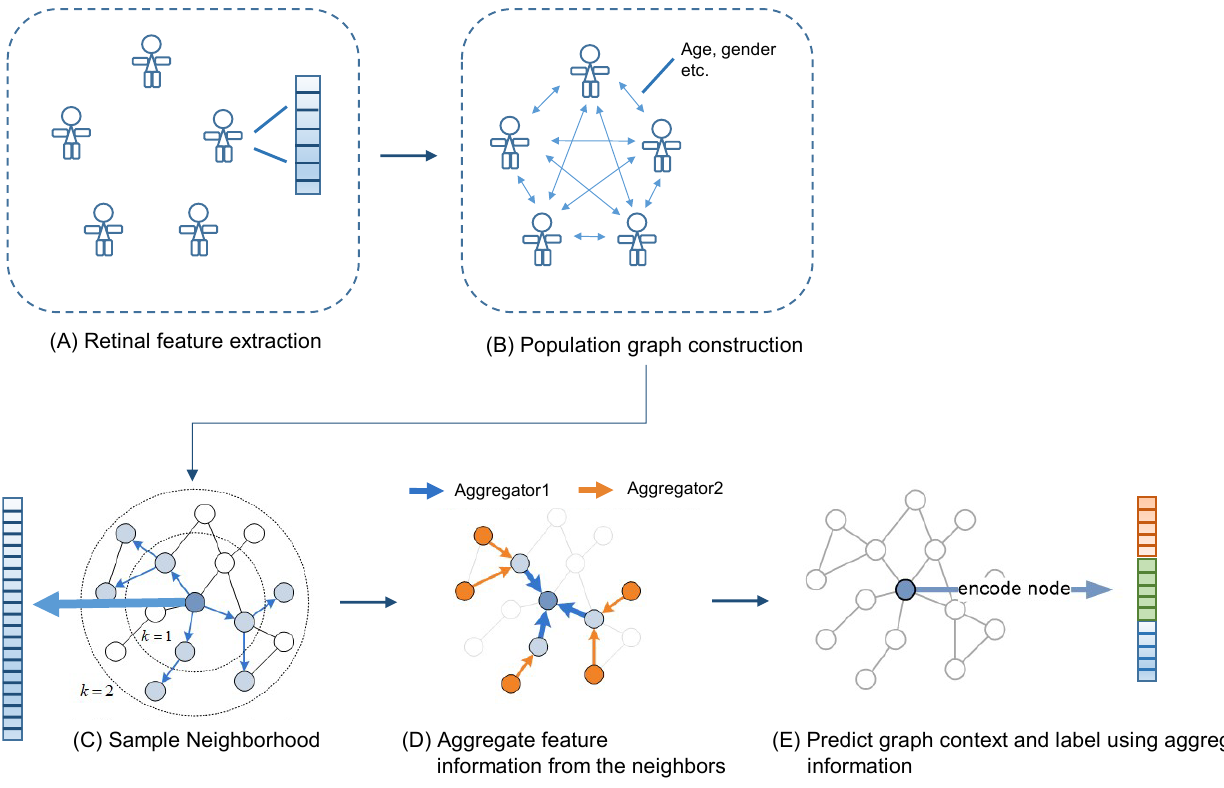
Figure 5. ( A – E ) The population graph was constructed in which the nodes represent the fundus images characterized by 96 retinal vascular biomarkers, and the edges were the similarity score determined by the age and gender of the subjects. A GraphSAGE network was applied to the constructed graph to predict CAD-RADS score of the